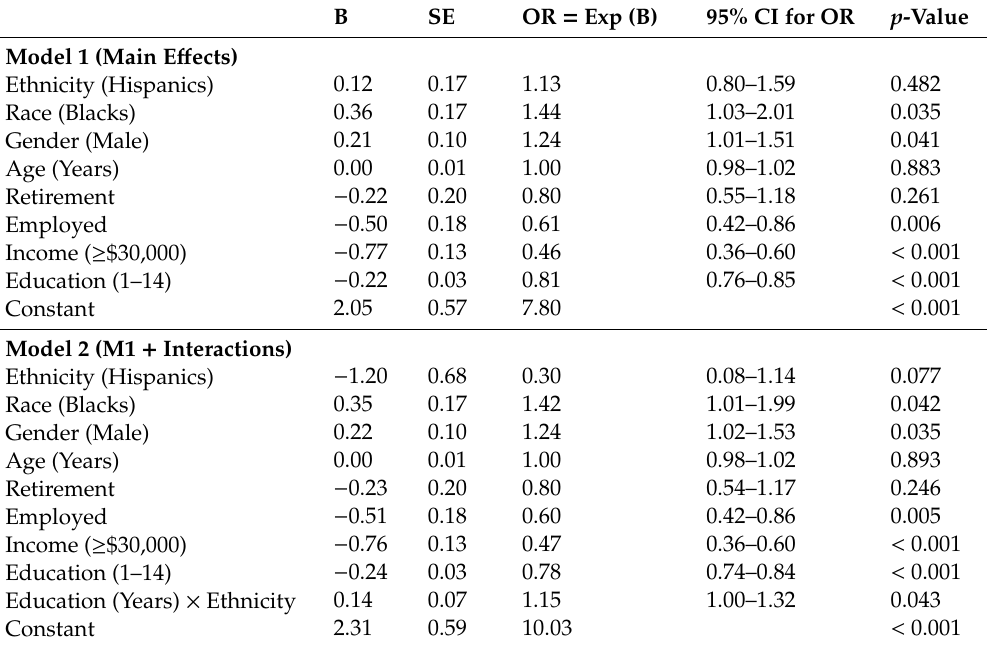
Table 3. Associations between educational attainment and poor oral health in the pooled sample. B SE OR = Exp (B) 95% CI for OR